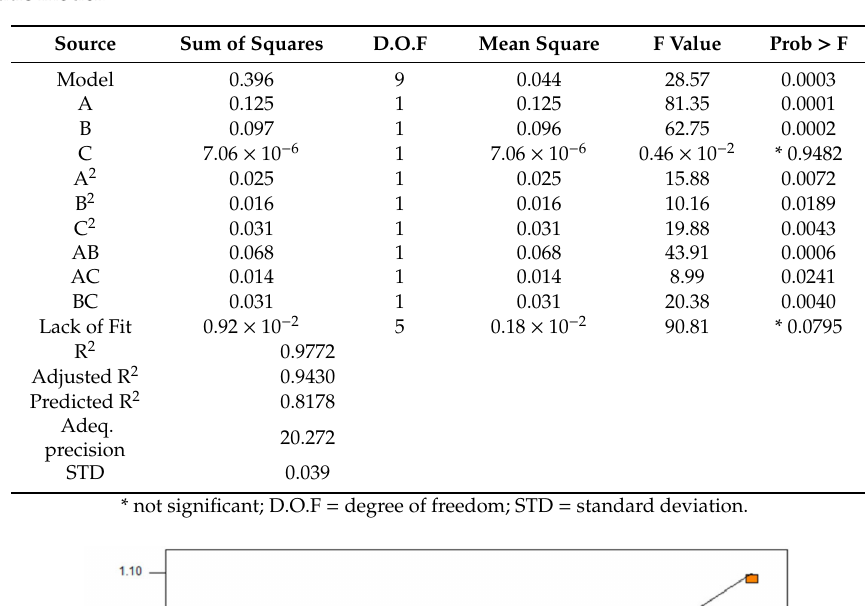
Table 2. ANOVA of the degree of substitution, degree of substitution (DS) for response surface quadratic model.